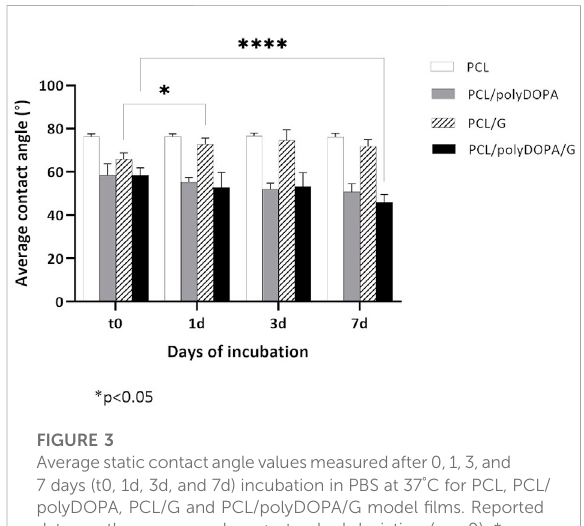
FIGURE 3 Averagestaticcontactanglevaluesmeasuredafter0,1,3,and 7 days (t0, 1d, 3d, and 7d) incubation in PBS at 37 ° C for PCL, PCL/ polyDOPA, PCL/G and PCL/polyDOPA/G model fi lms. Reported data are the average values ± standard deviation ( n = 9). * p -value <